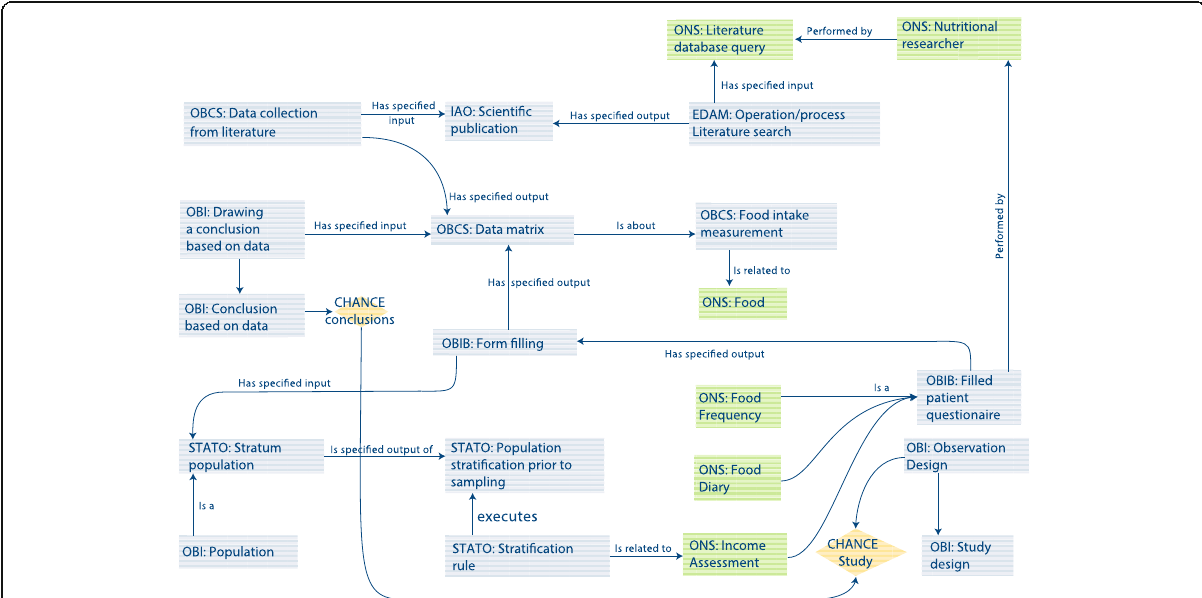
Fig. 2 Application scenario to the description of an observational study: modeling of the CHANCE study with the ONS. Terms in rhombus indicate instance-level terms specific to the CHANCE study (i.e., the specific conclusion of the CHANCE study), while terms in rectangular boxes represent general concept in the ONS. The presented semantic representation should be intended at the single instance level for the purpose of specifically describe CHANCE study